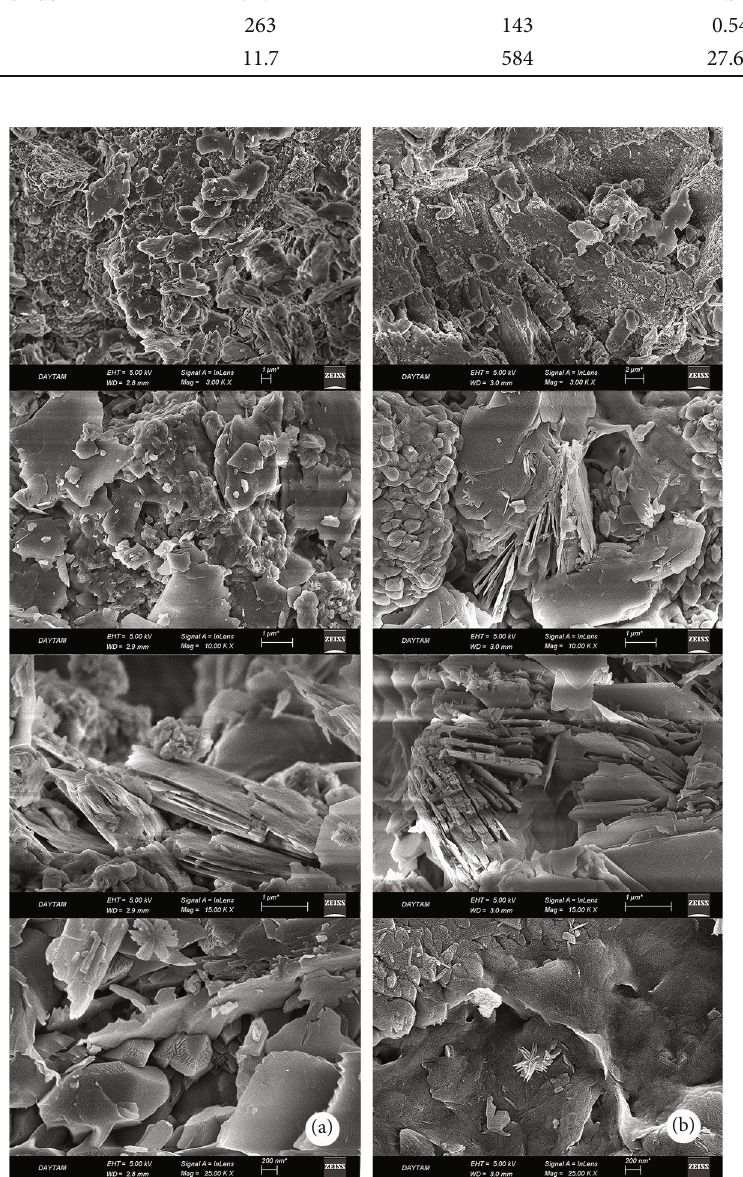
Figure 3: SEM images of MBS used in this study ((a) and (b) represent before and after adsorption,